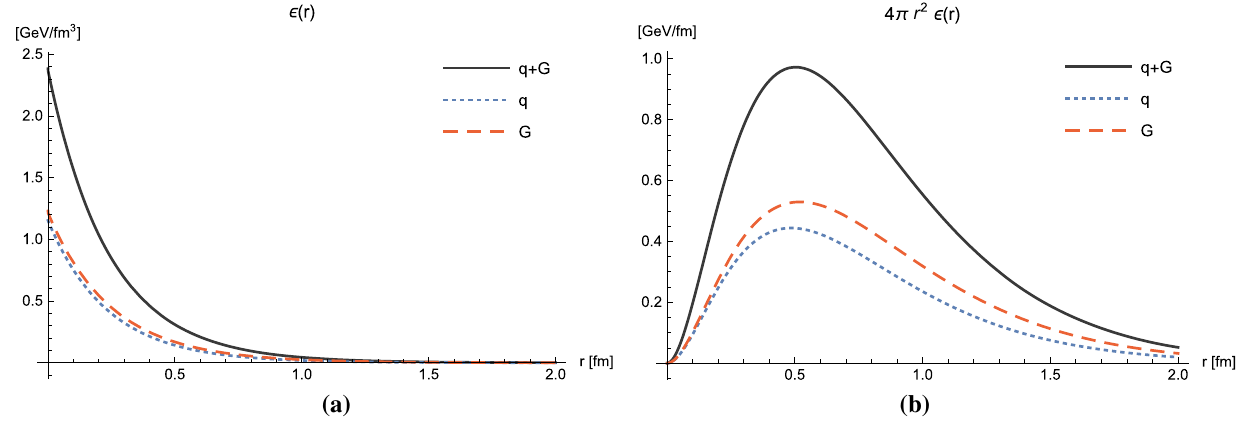
Fig. 2 Plots of the energy density, a (cid:14)( r ) and b 4 π r 2 (cid:14)( r ) , using the multipole model (11) with parameters given in Table 1, see Eq. (34) or Eq. (39) for the definition in terms of GFFs